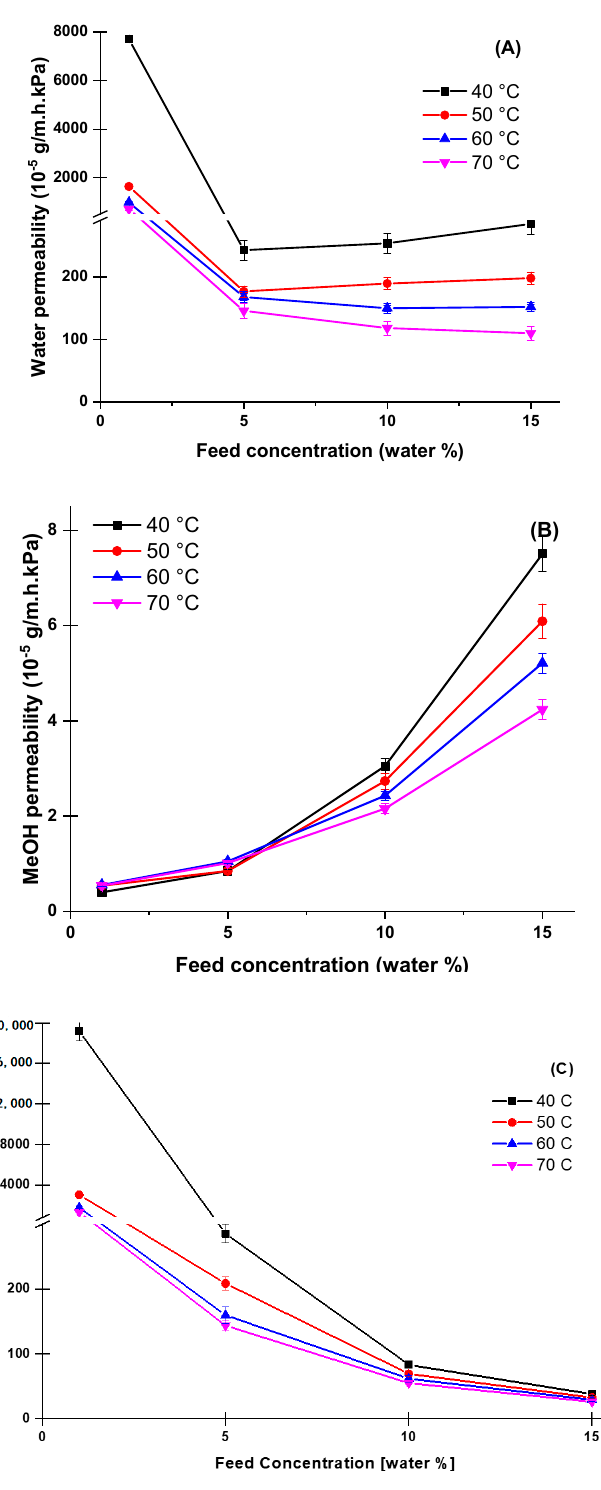
Figure 5. Intrinsic properties; water permeability ( A ), methanol permeability ( B ), and Selectivity( C ) of PVA10 as a function of water concentration in the feed solution at temperature ranges from 40 – 70 °C.